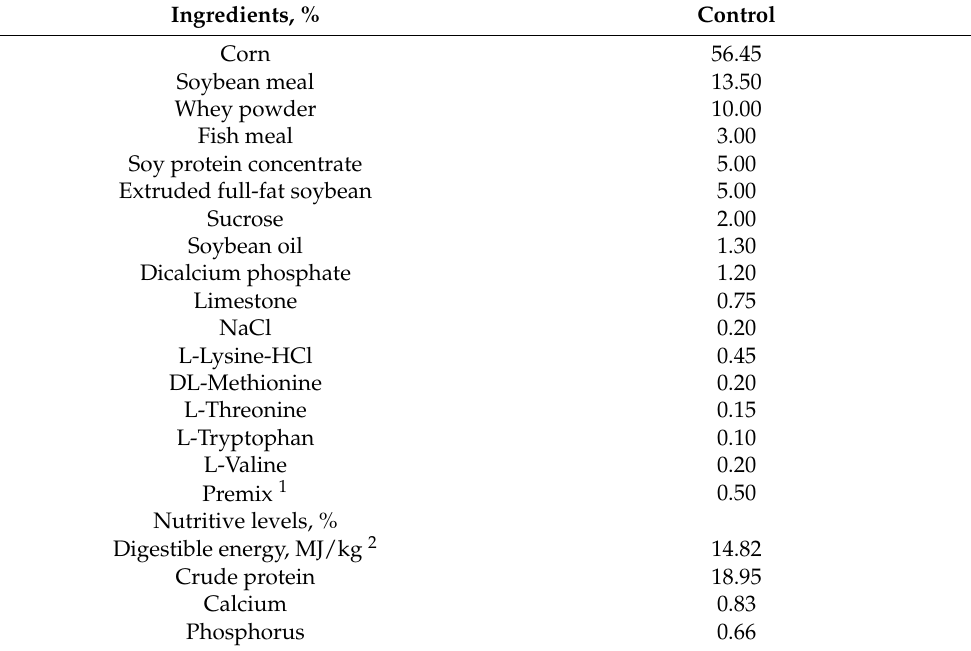
Table 1. Ingredients composition and nutritive levels of the control diet (%, as-fed